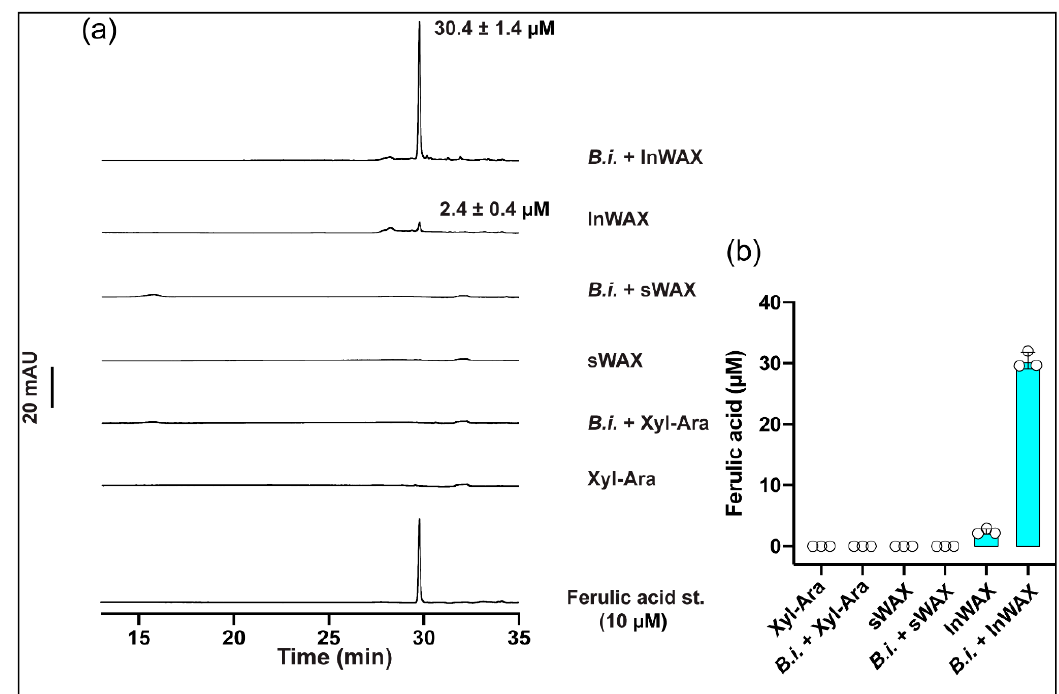
Figure 1 . Growth of Bacteroides intestinalis in minimal medium containing various substrates as the sole carbon source. ( a ) HPLC-DAD chromatogram of Bacteroides intestinalis culture supernatant from 24 h growth on monosaccharides (xylose + arabinose), soluble wheat arabinoxylan (sWAX), and insoluble wheat arabinoxylan (InWAX) as the sole carbon sourcesm showing the release of ferulic acid into the medium only on InWAX. ( b ) Quantification of ferulic acid released into the culture supernatant after 24 h growth. The results are mean ± S.D. of three replicates .